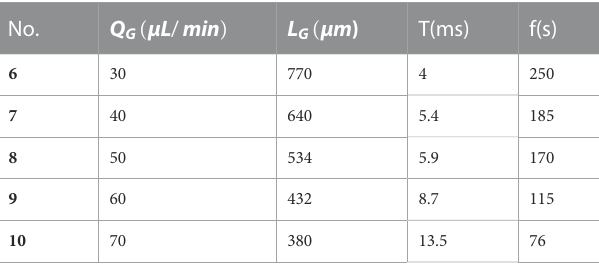
TABLE 6 Generation features of different liquid fl ow